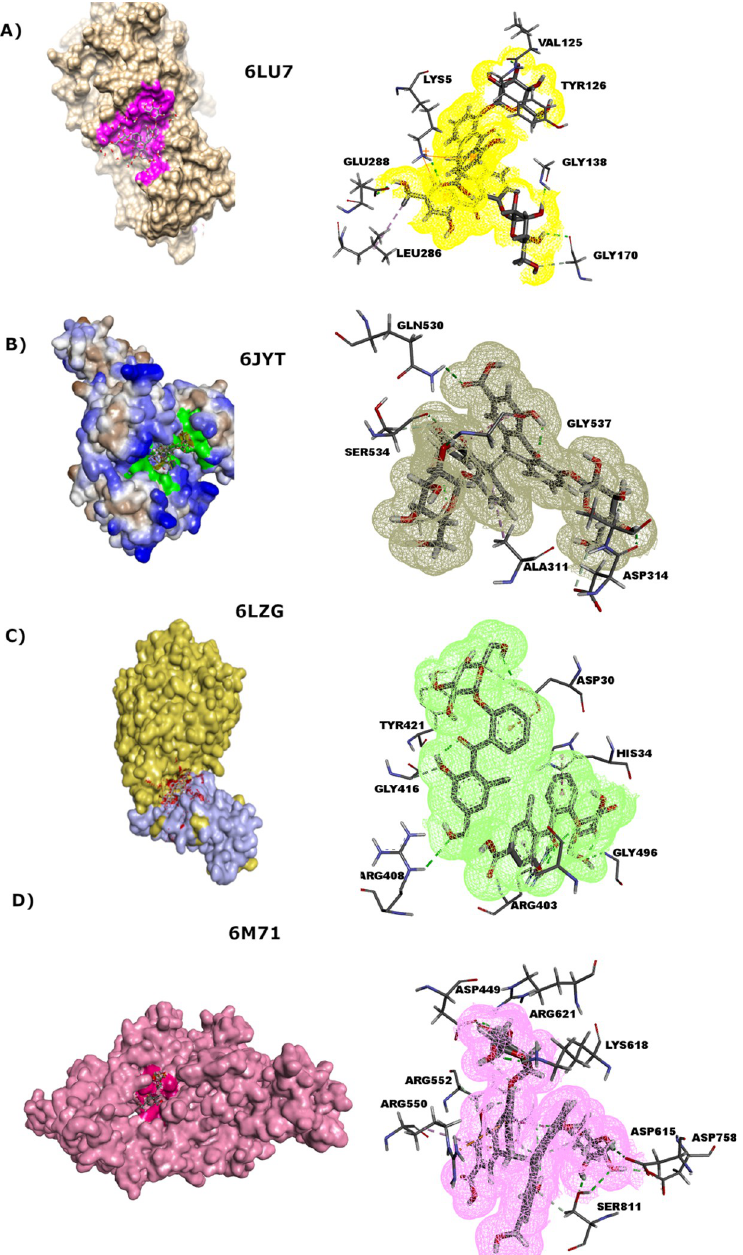
Fig 5. Preferred binding modes of sennosides docked with four essential proteins of SARS-CoV-2 depicting 2D binding interactions. a) 3CL pro b) Helicase nsp13 c) Spike protein-ACE2 receptor complex docked at two different sites d) RdRp